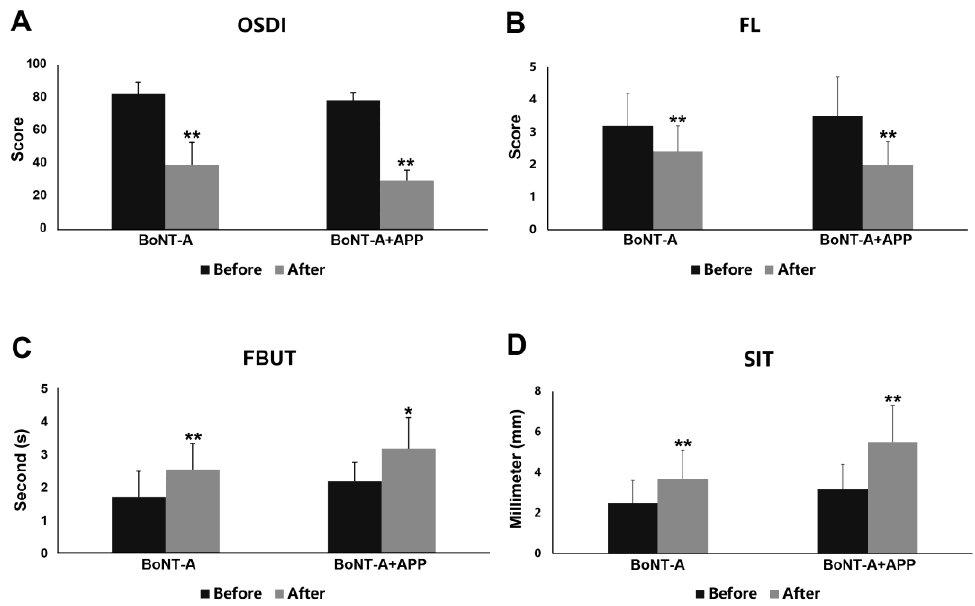
Figure 4. Dry eye symptoms and signs before and after treatment in the BoNT-A group and the BoNT-A+APP group. ( A ) OSDI score, ( B ) FL score, ( C ) FBUT (s) and ( D ) SIT (mm/5min). * p < 0.05, ** p < 0.01.